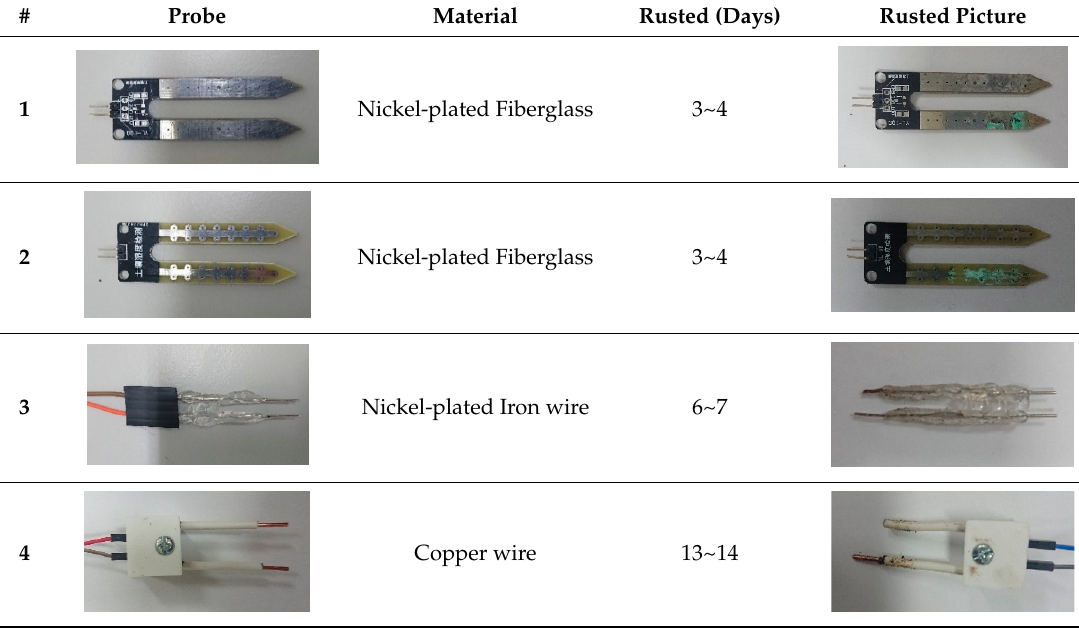
Table 2. Material for designing the soil probe.